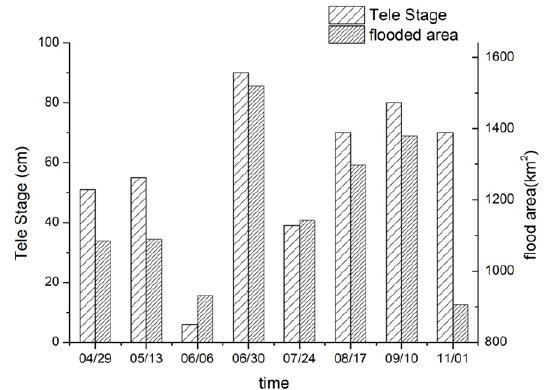
Figure 4. Monthly dynamics of the flooding extent derived from multitemporal Radarsat synthetic aperture radar (SAR) images and water level derived from hydrological station in 2015.